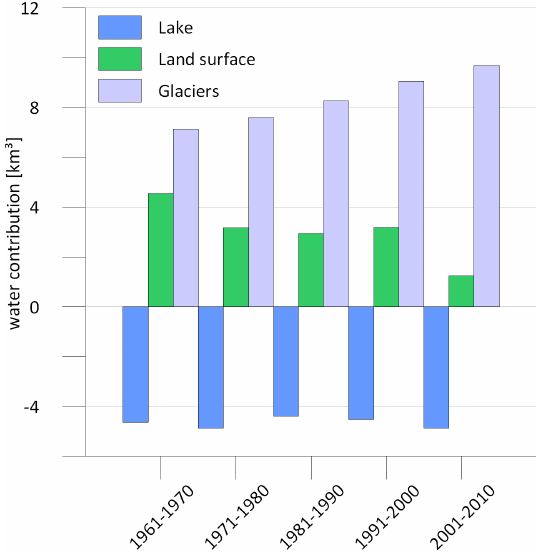
Fig. 6. Absolute water contribution to Nam Co lake in km 3 from the three different land cover types.